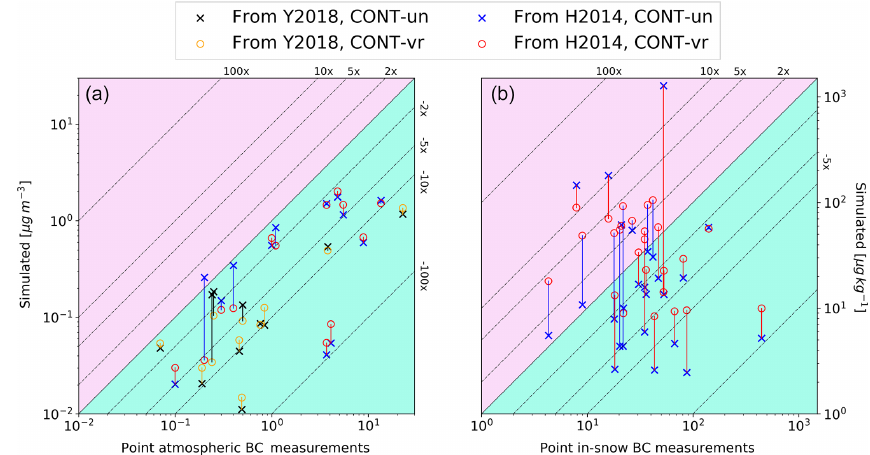
Figure 4. Observed versus simulated (a) atmospheric and (b) in-snow BC. Observations are summarized in He et al. (2014; H2014) and Yang et al. (2018; Y2018). Pink (sea foam) denote areas where simulations overpredict (underpredict) BC. The vertical lines connect iden- tical observation points from CONT-vr and CONT-un, while the color of each line indicates which experiment is closer to observed BC measurements. The thin solid black diagonal represents the 1-to-1 curve, while the thin dashed diagonals represent factors of underprediction or overprediction by CESM